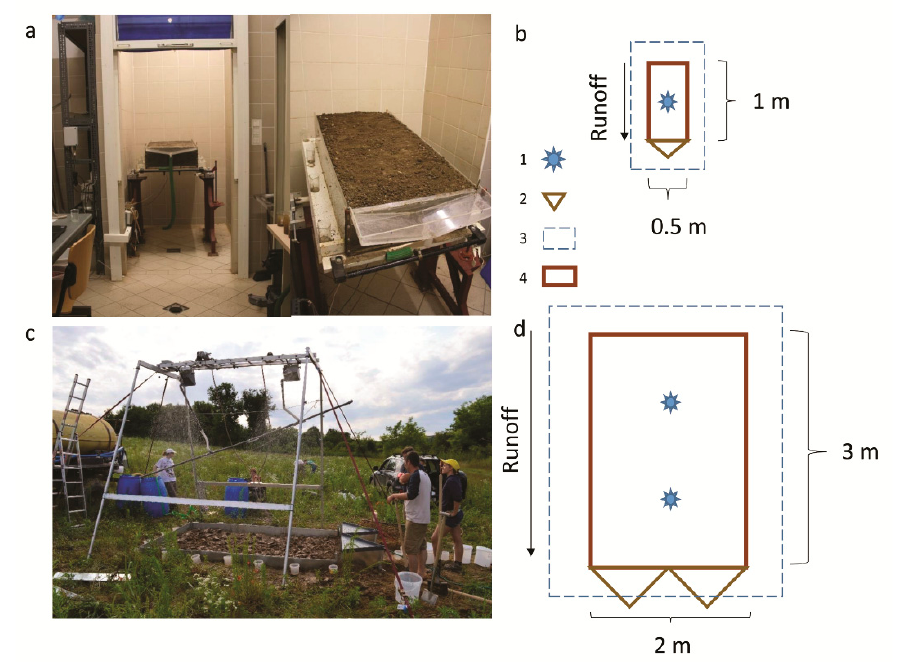
Figure 2. Photographs of the lab ( a ) and field ( c ) simulations and their primary parameters (( b , d ), respectively) of the simulators used during the study. Marker explanation: (1) nozzle position; (2) triangular collector; (3) irrigated area; (4) plot boundary.